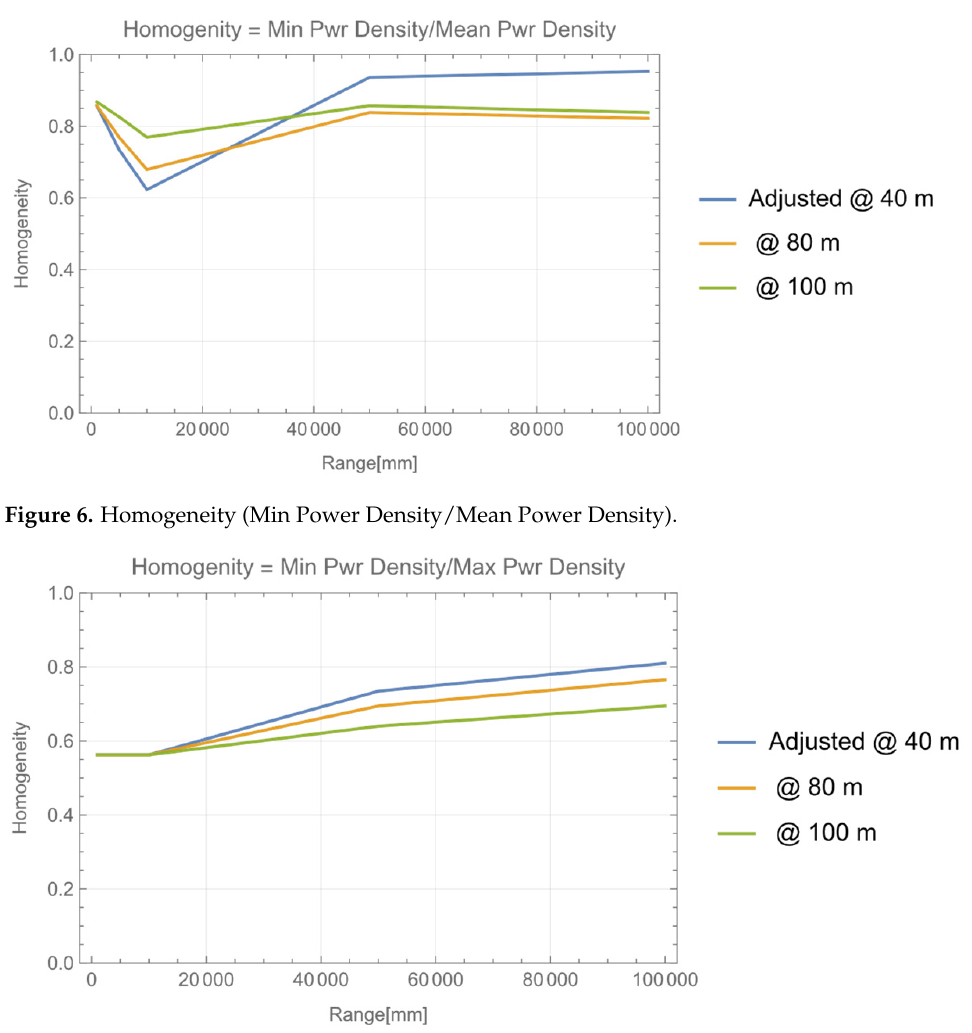
Figure 7. Homogeneity (Min Power Density/Max Power Density).